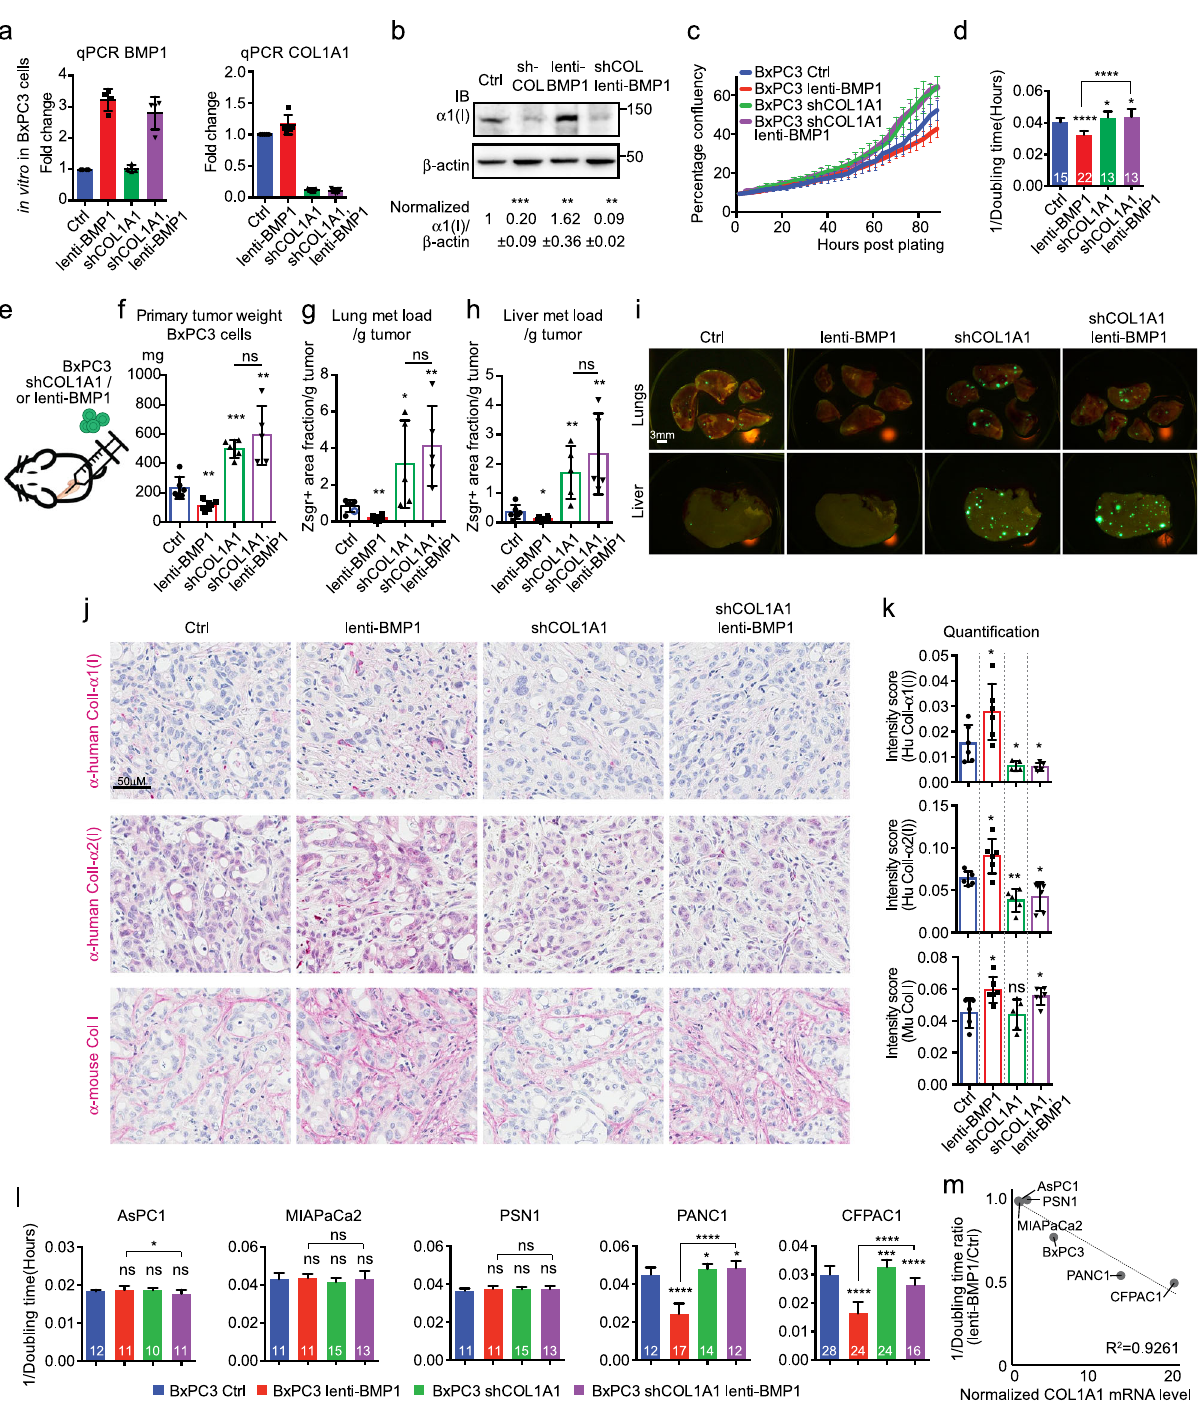
the cleavage of mini-pro α 1(I) by BMP1 in vitro (Fig. 6b). We